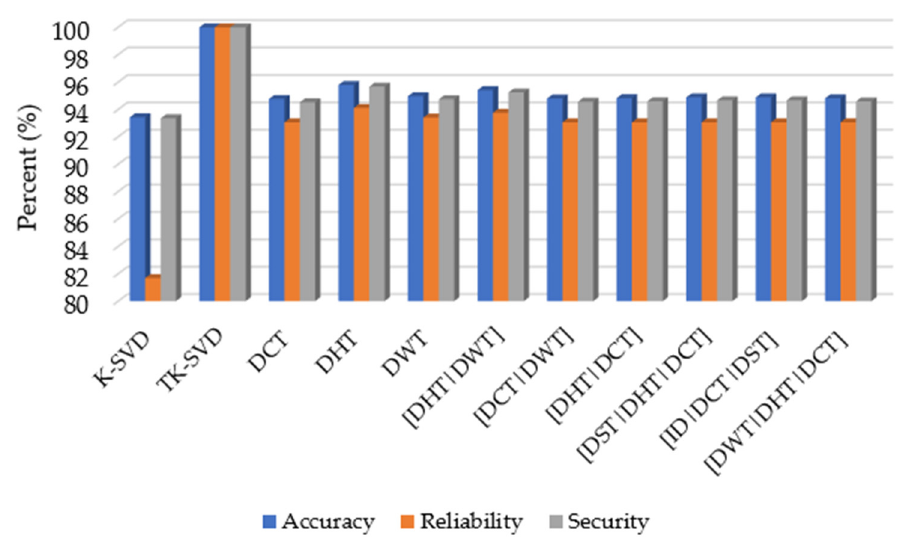
Figure 11. Comparison of adaptive, singles, and hybrids with two and three overcomplete dictionary learning.